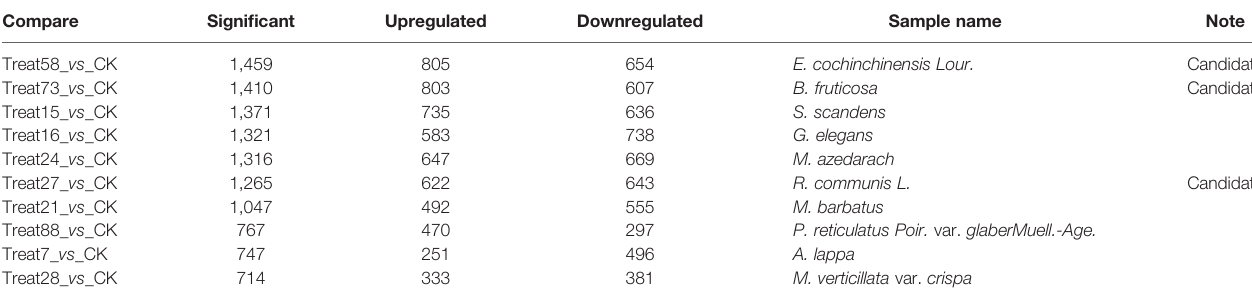
TABLE 2 | Differential gene expression of the top 10 sets in condition